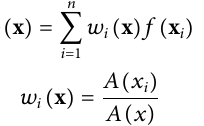
Frontiers in Robotics and AI |